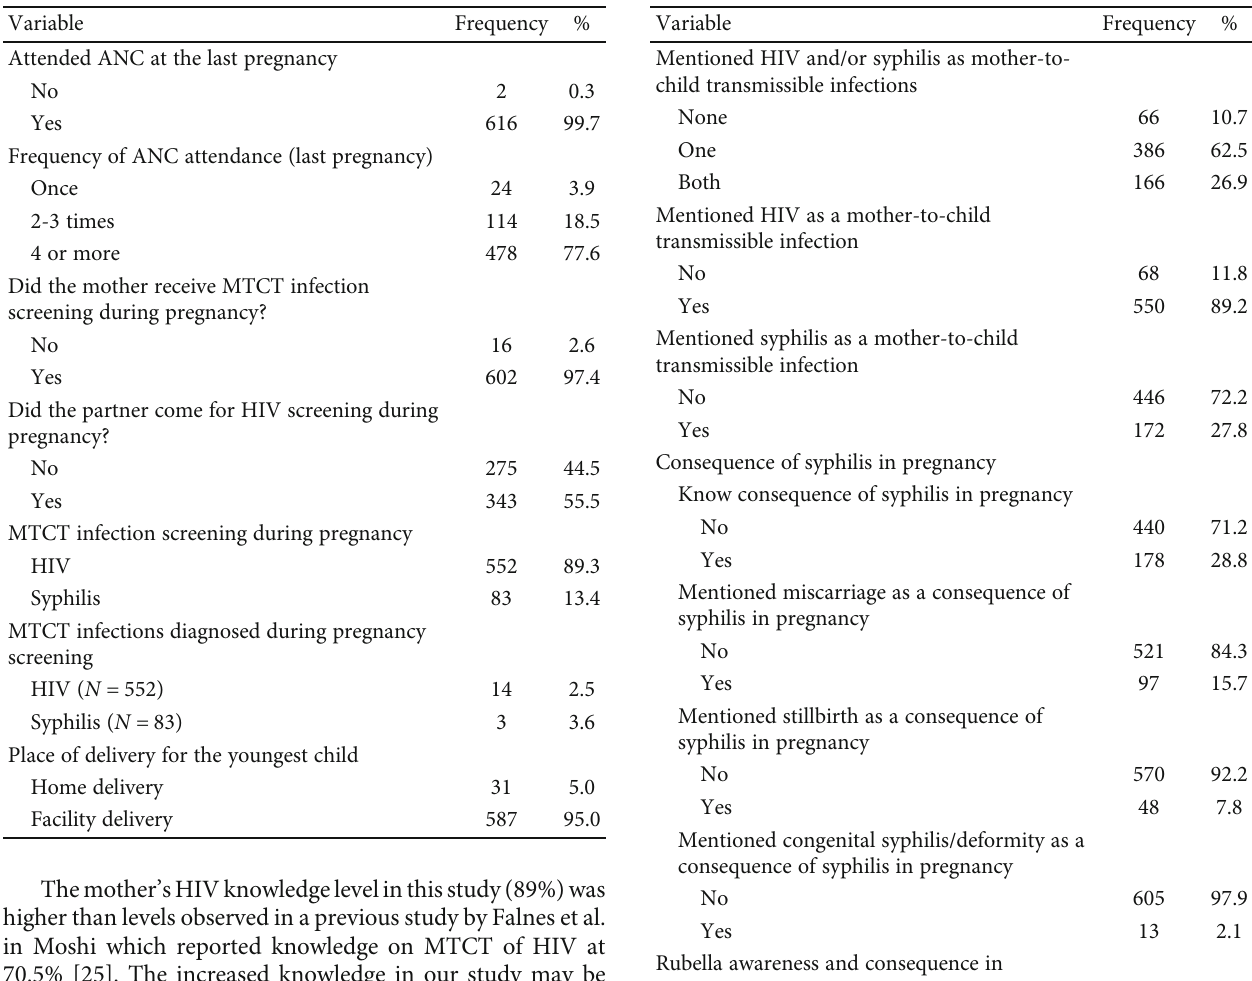
Table 2: Reproductive and maternal history among 618 women in the Kilimanjaro region.